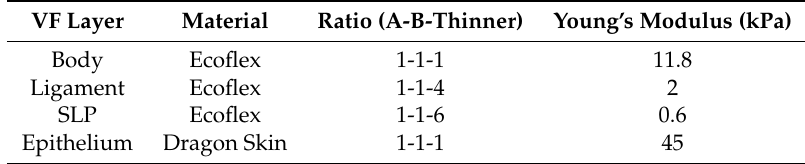
Figure 1. ( a ) Model of the geometry of the silicone vocal folds; and ( b ) image of the experimental flow facility. Table 1. Different mixture ratios of silicone and their corresponding Young’s moduli. A ratio of 1:1:x means that the layer was formed by mixing 1 part A, 1 part B, and x parts thinner by